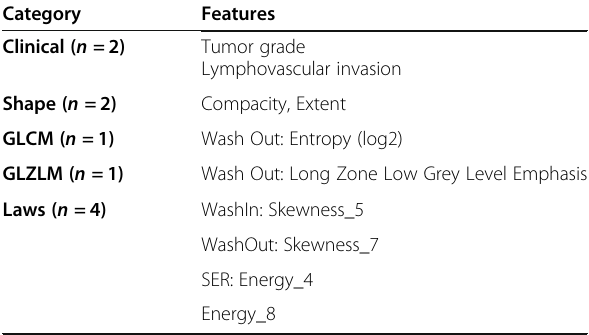
Table 3 Features chosen by CR model for intratumoral features only. This model included 2 clinical features and 8 radiomic features